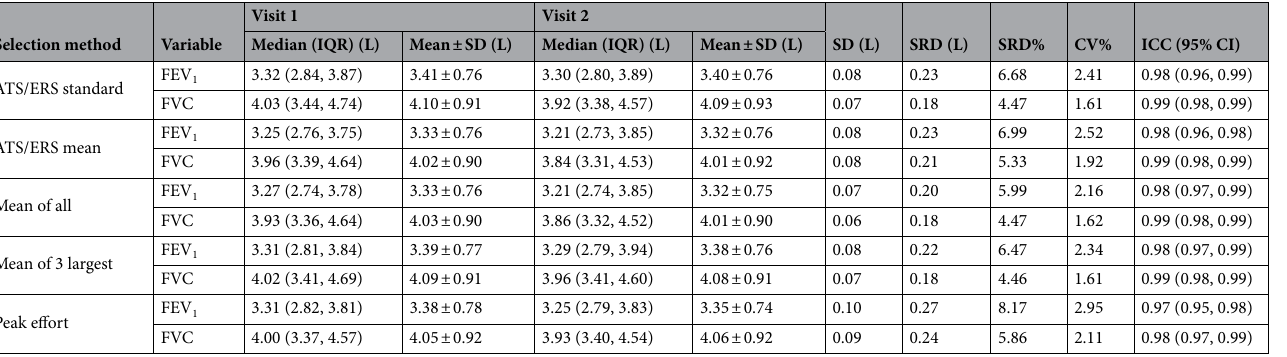
Table 5. Inter-session descriptive statistics and variability by selection method for forced vital capacity (FVC) and forced expiratory volume in one second (FEV 1 ) (n = 156; 78 per visit). ATS/ERS refers to the current selection method recommended by the American Thoracic and European Respiratory Societies. Data for descriptive statistics are presented as mean ± 1 standard deviation (SD) and median (interquartile range, IQR). SD = measurement error taken as root mean square error (standard deviation) from fitted linear mixed effects model; SRD = repeatability or smallest real difference (SRD) = SDx2.77; SRD% = SRDx100/mean across both visits for outcome measure; CV% = (SD/mean) × 100 across both visits for outcome measure; ICC = intraclass correlation coefficient; 95% CI = 95% confidence interval (lower, upper).